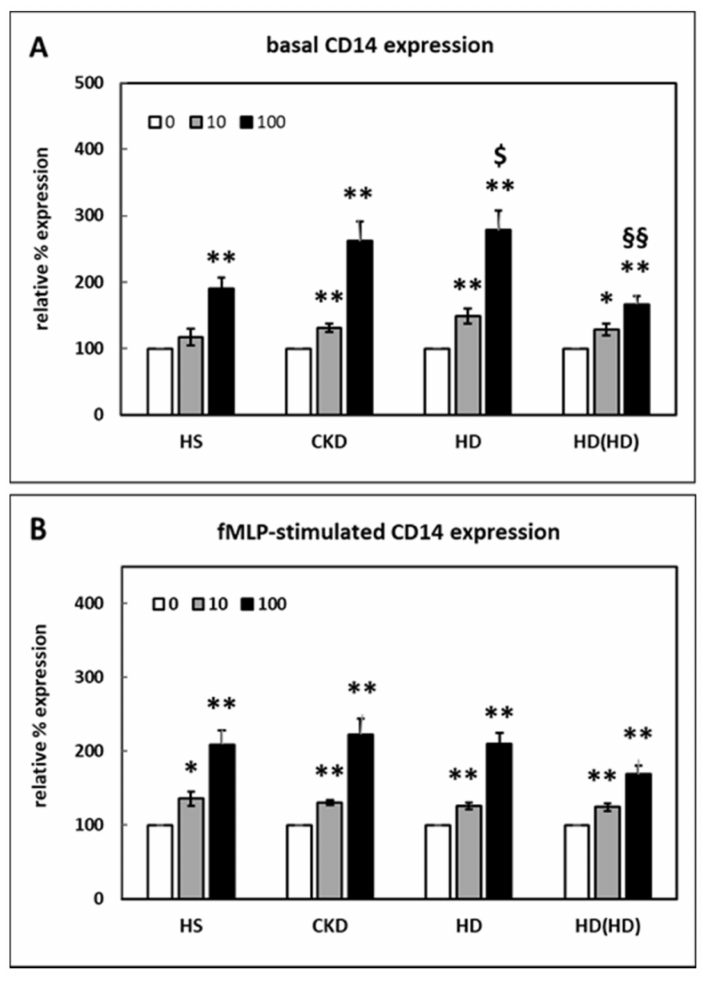
Figure 1. Effect of high-density lipoprotein (HDL) from healthy subjects (HS), n = 7, chronic kid- ney disease (CKD) patients stage 3 and 4 (CKD), n = 18, hemodialysis (HD) patients (HD), n = 8, on polymorphonuclear leukocytes (PMNLs) from healthy subjects at 0, 10 and 100 µ g/mL final concentration. HD(HD): Effect of HDL from HD patients on PMNLs from HD patients, n = 9; the percentage of CD14 positive cells in the absence of HDL was set as 100%. There was no statistically significant difference between the absolute values. ( A ) Basal CD14 surface expression. ( B ) CD14 surface expression stimulated by N-formyl-methionyl-leucyl-phenylalanine (fMLP). * p < 0.05 and ** p < 0.01 versus 0 µ g/mL HDL; $ p < 0.05 versus HS; §§ p < 0.01 versus HD; data shown are mean values ± standard error of the mean